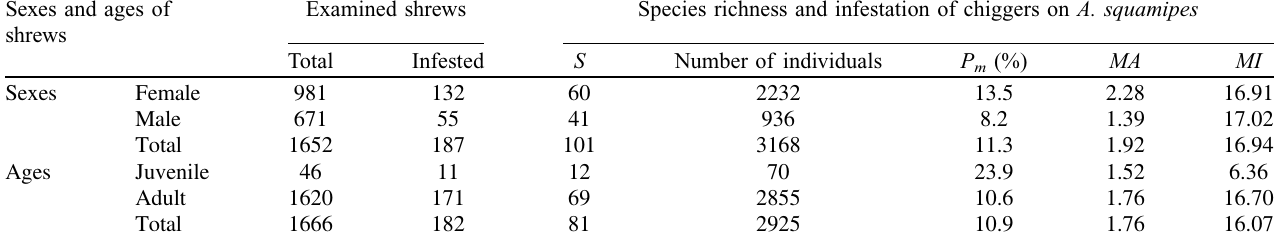
Table 5. Chigger infestation on different sexes and ages of Anourosorex squamipes shrews in Southwest China (2001 – 2019). Sexes and ages of